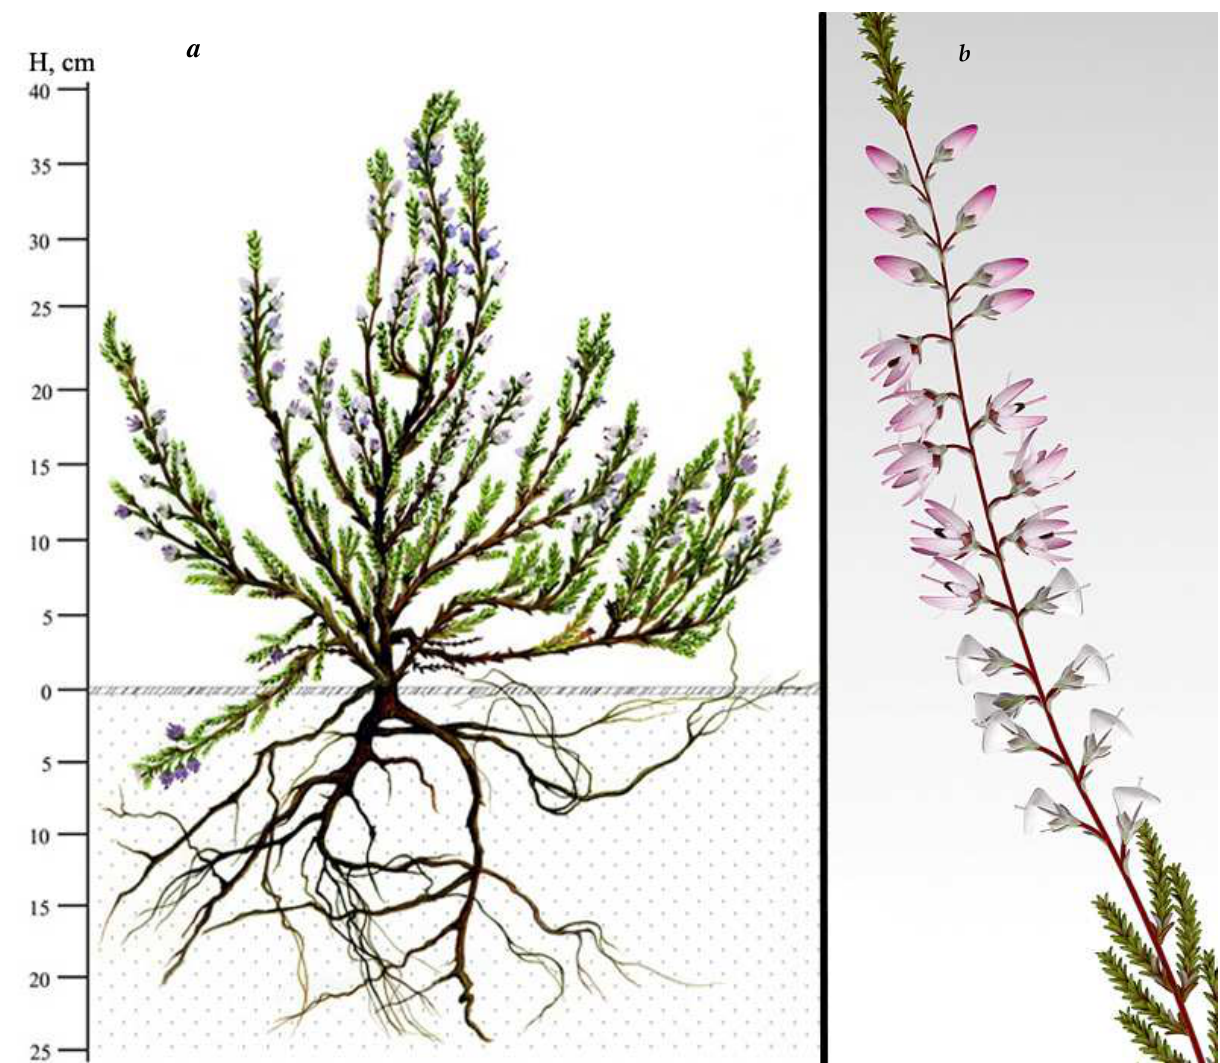
Figure 6. General view of ( a ) C. vulgaris 20-years-old adult (origin from seed) growing in Pritobolye, Western Siberia (Zavodouspenskoe); ( b ) Enlarged part of an annual shoot with leaves and inflorescences (3D- visualization).